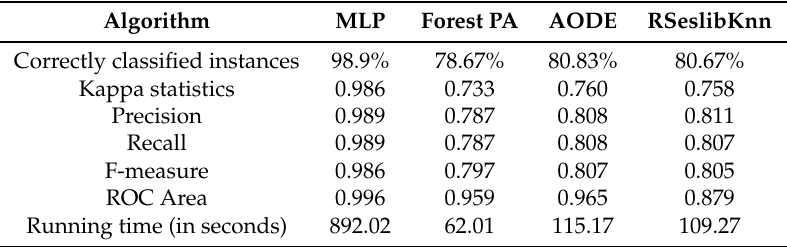
Table 2. The performance for each of the applied algorithms after attribute selection.